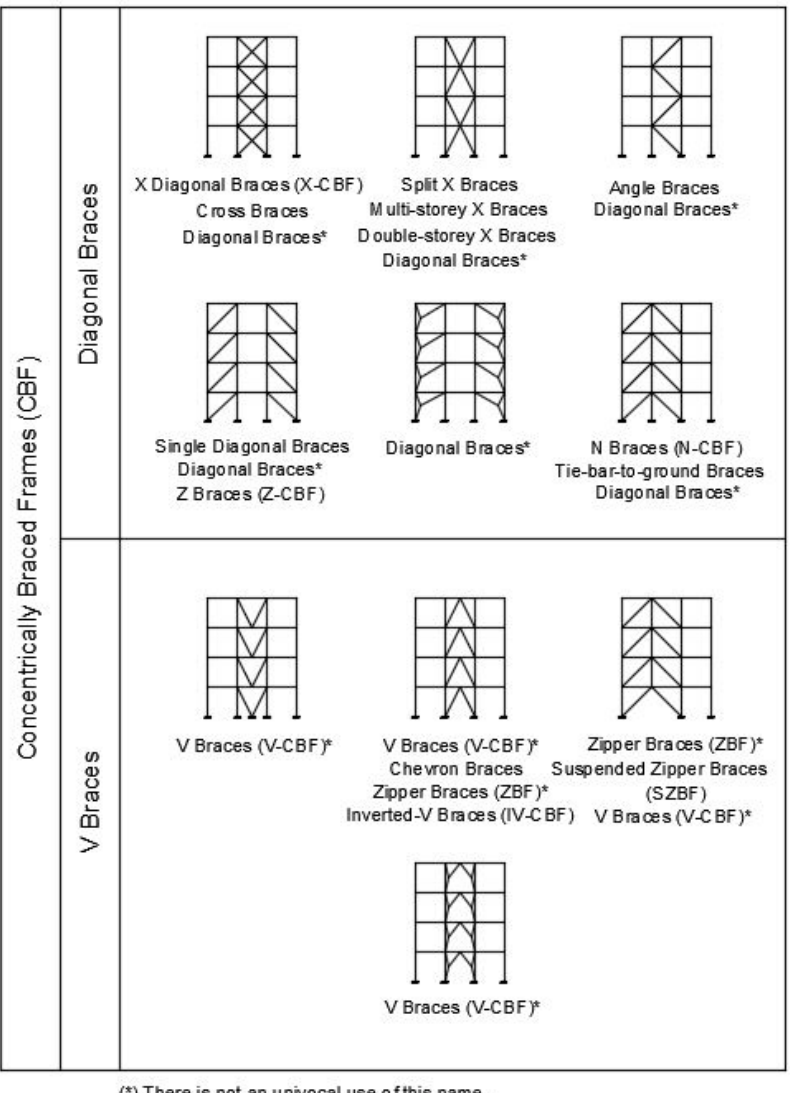
Figure 11. Nomenclature for the main types of concentrically braced frames.